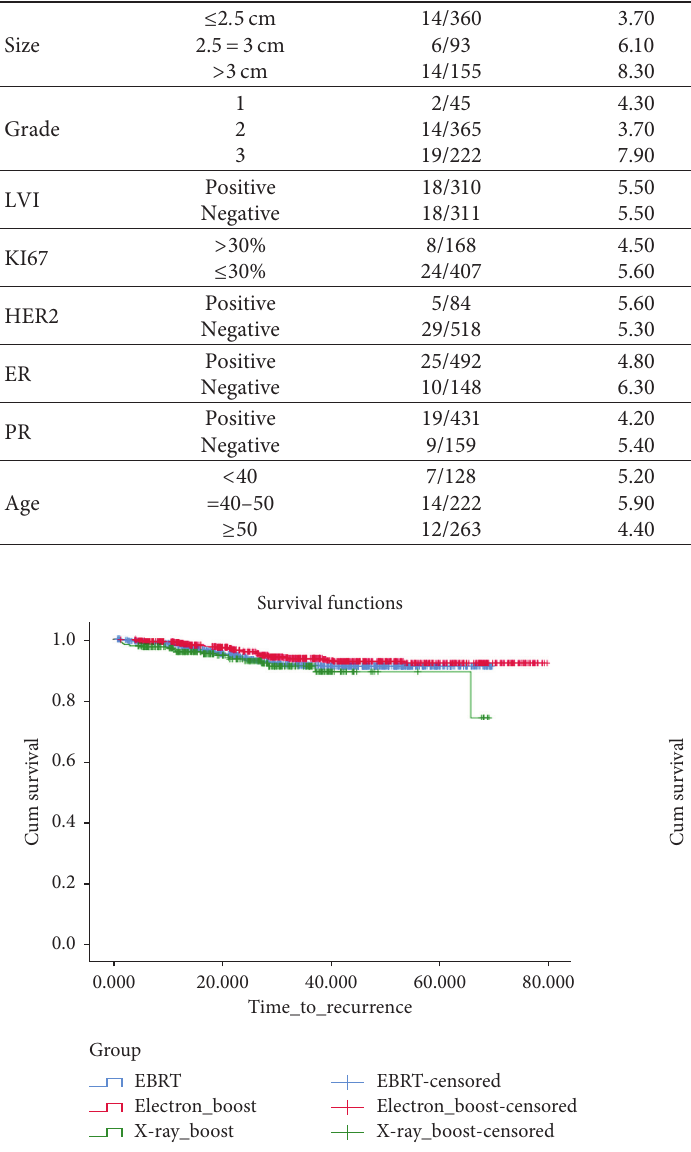
Figure 2: Cumulative incidence of overall survival in boost groups in comparison with